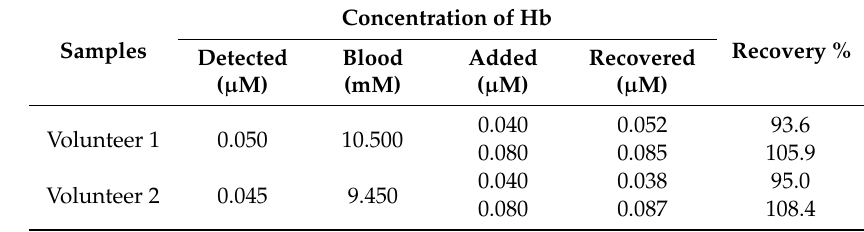
Table 2. Hb determination in real blood